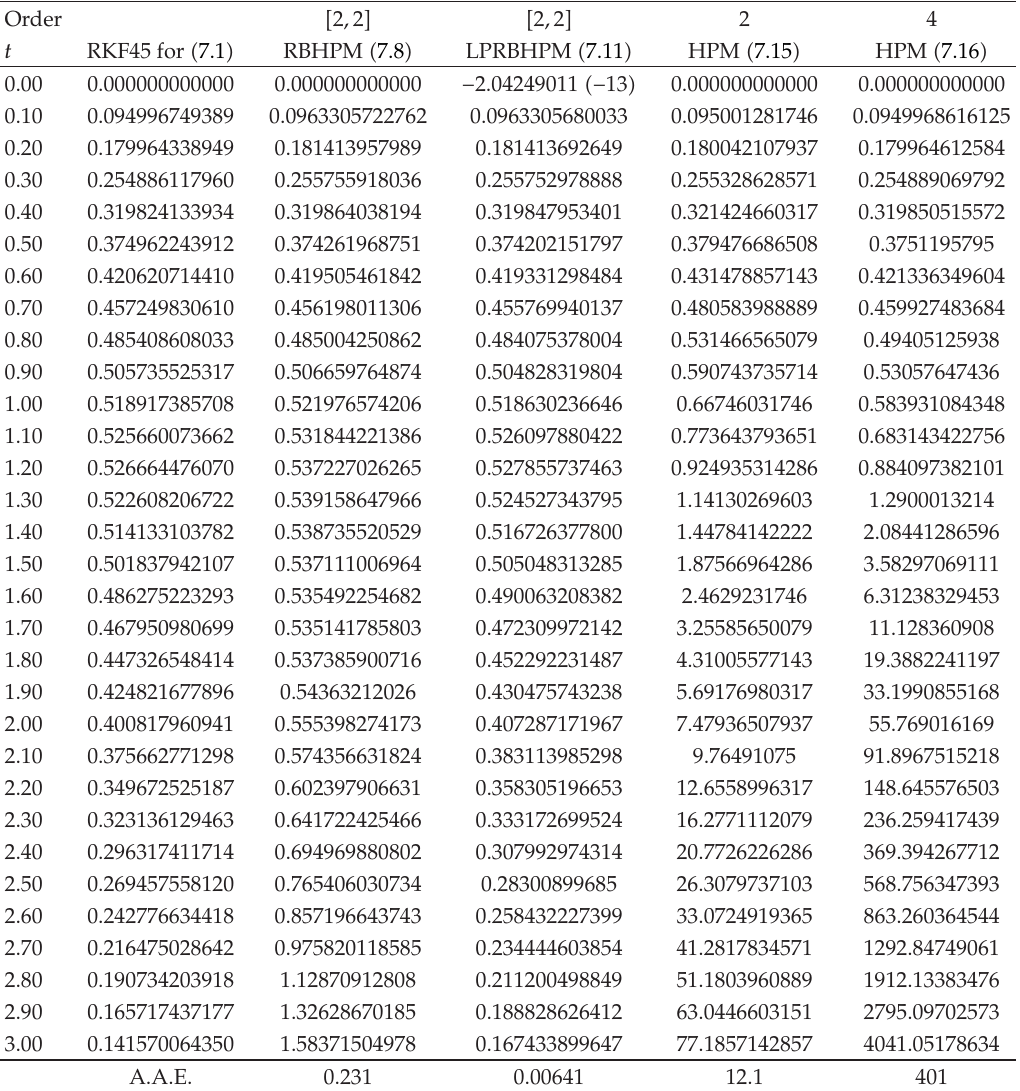
Table 2: Comparison numerical solution (cid:3) RKF45 (cid:4) for (cid:3) 7.1 (cid:4) and its first order approximate solutions